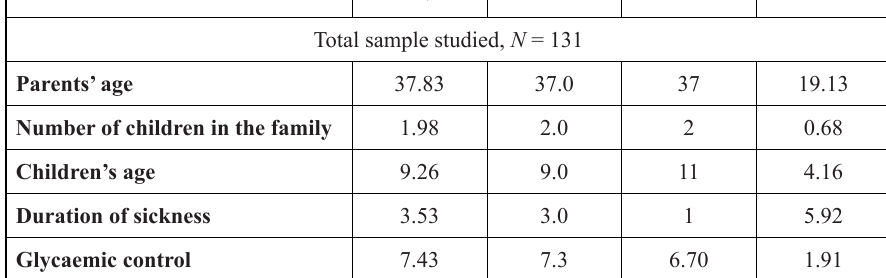
social characteristics of the total sample and subsample